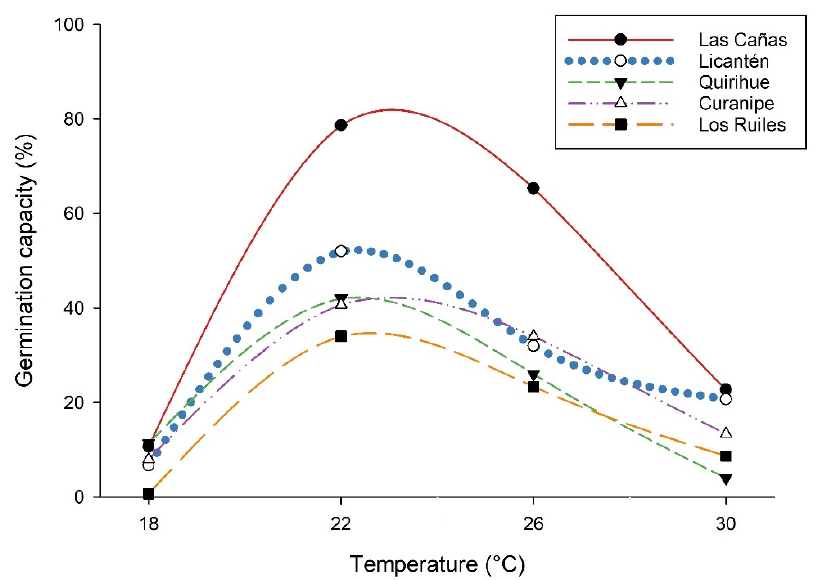
Figure 2. Final germination percentage of five provenances of Nothofagus glauca seeds treated at different temperatures in the absence of light.